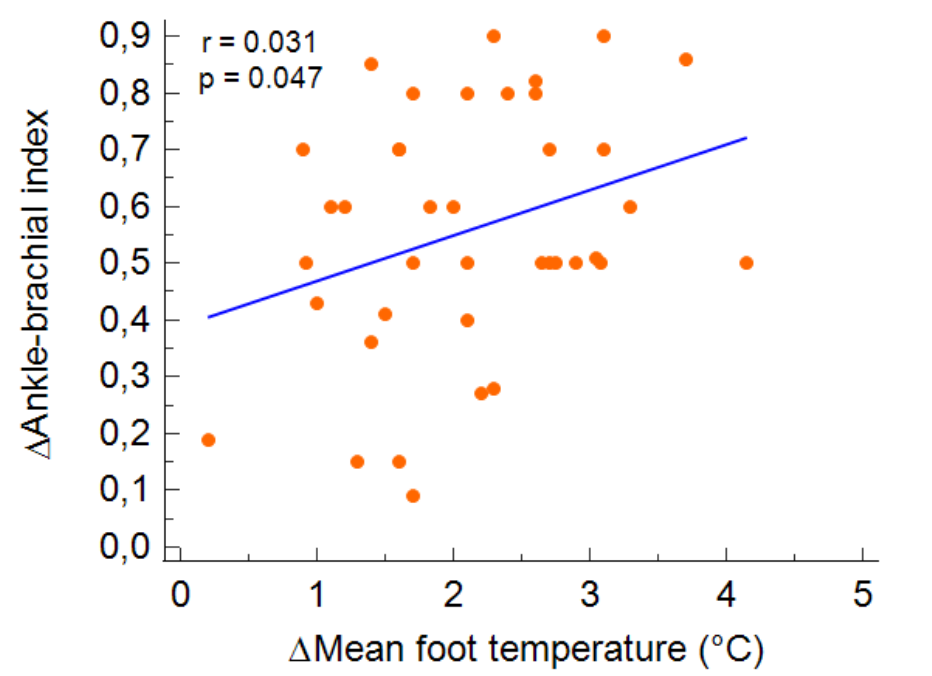
Figure 3. The correlation between the variations of mean temperature and ABI after the revascularization in the treated limb. ization in the treated